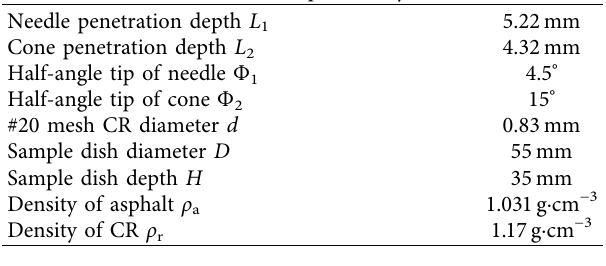
Table 5: Parameters of probability